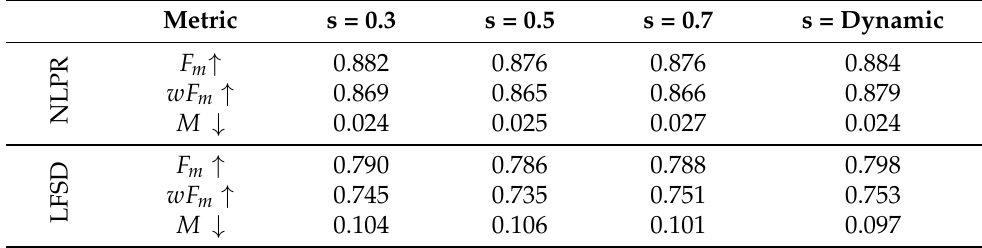
Table 5. Distillation on VGG16 with RGB maps. ↑ and ↓ indicate that larger and smaller scores are